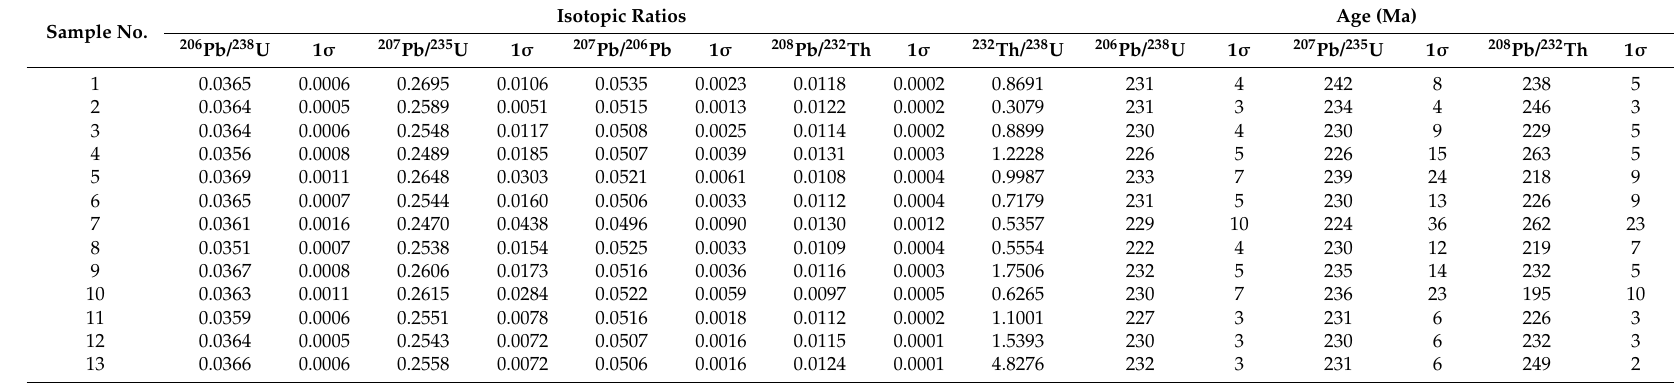
Table 1. LA-ICP-MS zircon U-Pb analysis results for the syenite in the Saima deposit.